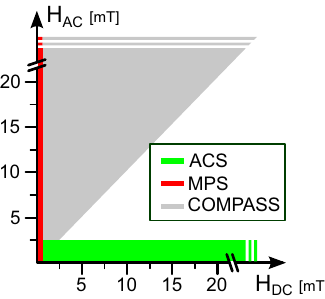
the critical point (CP). d In the vicinity of a CP, the position, which is most sus- ceptibletothesampleparameters,thephase φ ( H DC )ofthesignalshowsanapprox. 180° degree shift with a strong slope. Thus, even minimal changes in the sample parameters and thus in the shape of the A n ( H DC ) and φ ( H DC ) curves result in high changes in the phase φ ( H DC ) and thus in the resulting signal. The sixth and ninth harmonicare integermultiples of three and thereforehappentoalso vanish in this case (gray